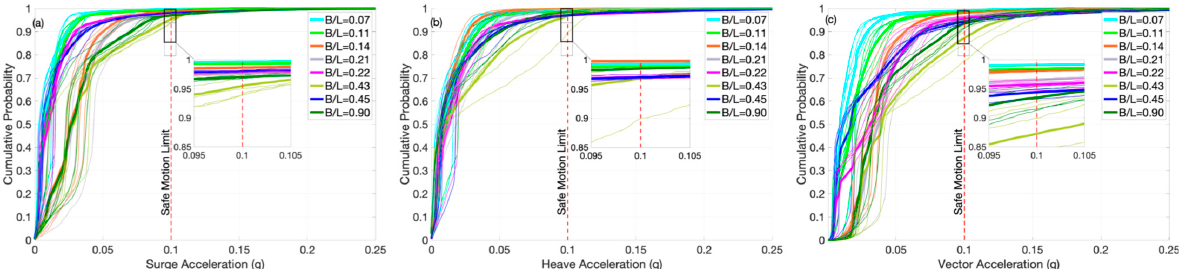
Figure 8. Cumulative probability distributions of measured accelerations of all 5 sensors for ( a ) surge; ( b ) heave; and ( c ) vector. ( b ) heave; and ( c ) vector.